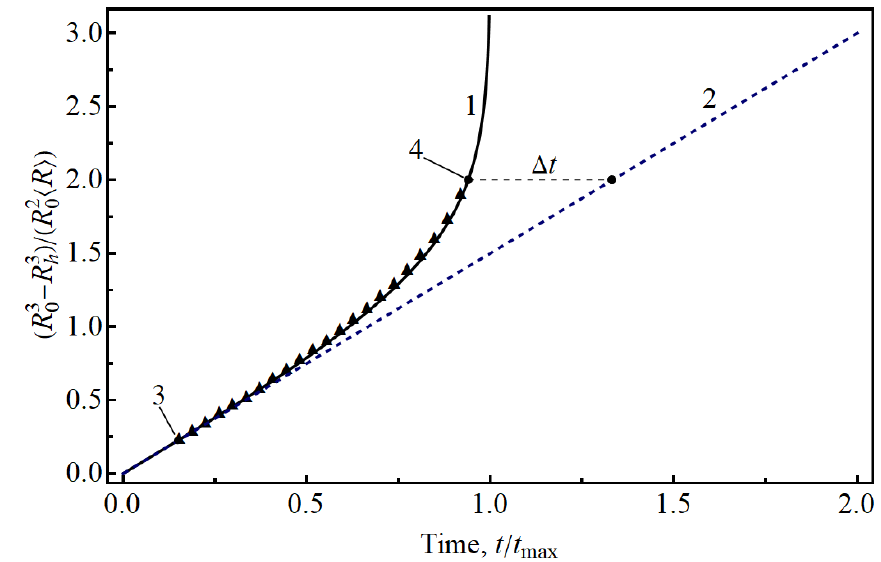
Figure 6. The time-dependence of concentration wave position R h in dimensionless units for cathode particle with the size of R 0 = 0.2 µ m at the double-phase stage. The particle is the part of ensemble described by PSD given by Equation (10) with (cid:104) R (cid:105) = 0.1 µ m and m = 4. Solid line 1 corresponds to solution of Equation (11). Dashed line 2 is the linear dependence corresponding to constancy of the interfacial flux density. Points 3 and 4 correspond to moments of start and finish of double-phase stage for the particle. Triangle points correspond to solution of the CH equation.